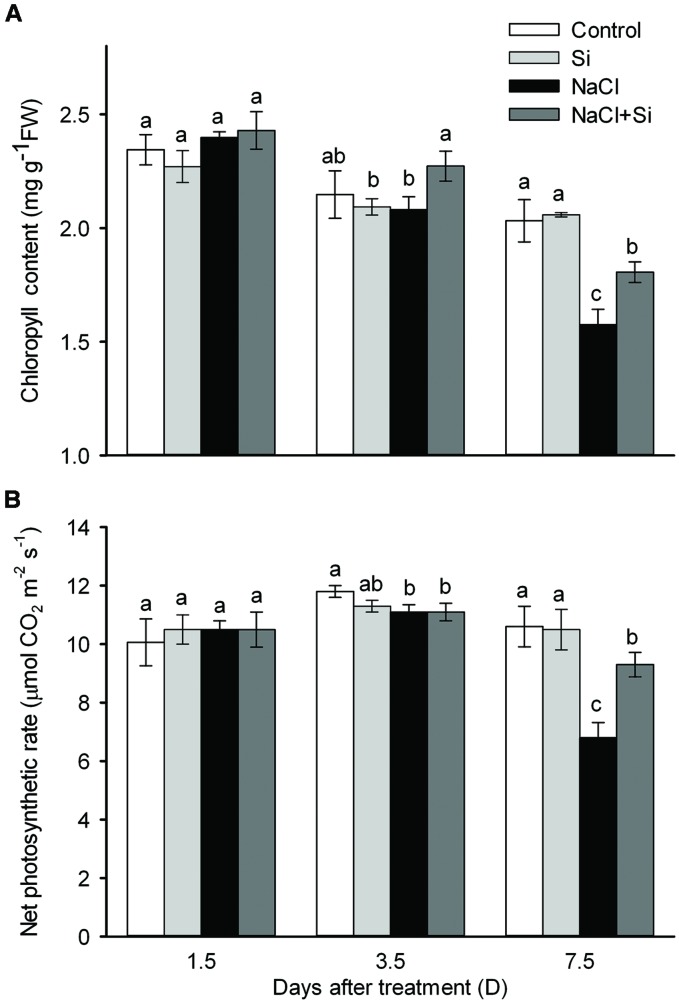
Effects of silicon (0.83 mM) and salt stress (65 mM) on leaf chlorophyll concentration (A) and net photosynthetic rate (B). All parameters were measured after 1.5, 3.5, and 7.5 days of salt treatment. Vertical bars represent the standard deviations (n = 3). Different letters at the same time point represent significant differences (p < 0.05) between the treatments. Sharing the same letter indicates no significant difference between the treatments.